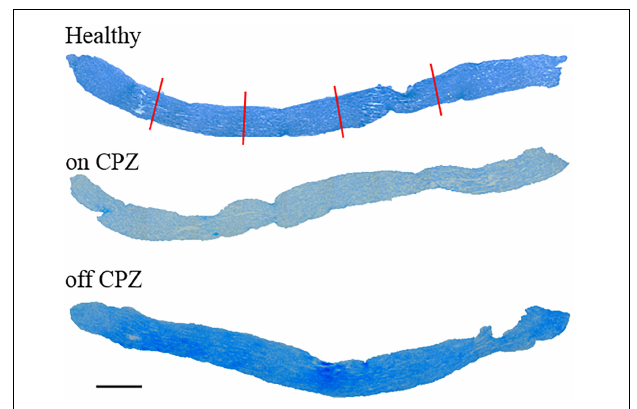
FIGURE 1 | Longitudinal optic nerves were stained by Luxol Fast Blue for each group. Red lines represent the thickness measure. Scale bar, 200 µ m.